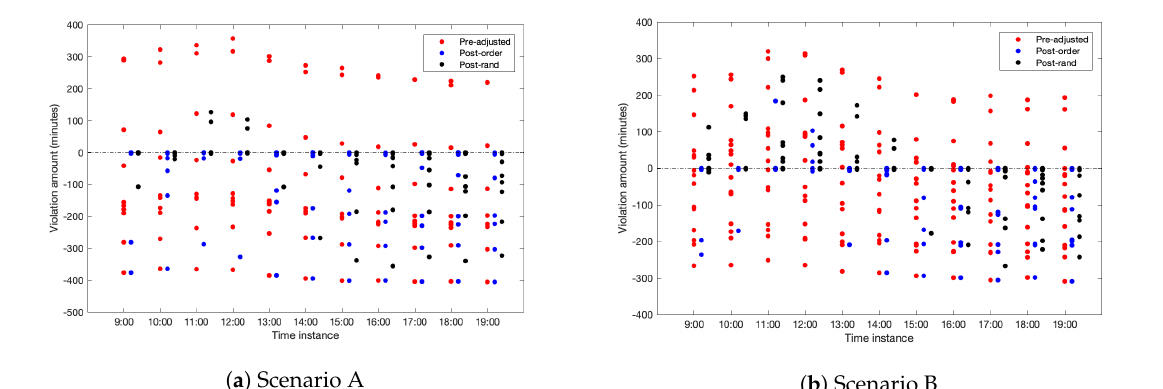
Figure 7. Effect of assigning a customer in a random fashion versus ascending order of travel time to the nearest non-violating vehicle in Step 4 of Algorithm 2. Red: Phase I; blue: Phase II with ascending order assignment; black: Phase II with random